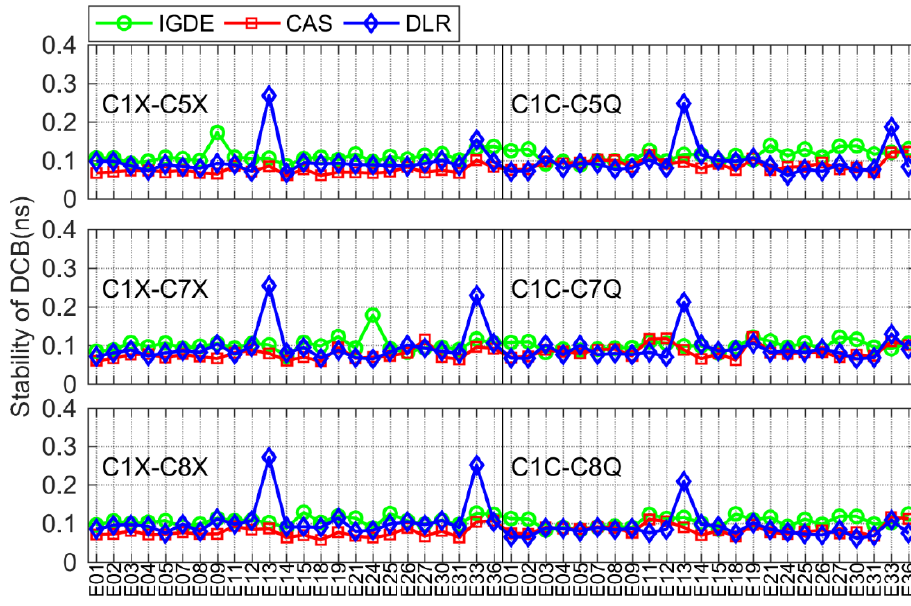
Figure 15. Stability of the Gaileo DCB obtained by IGDE, CAS, and DLR.